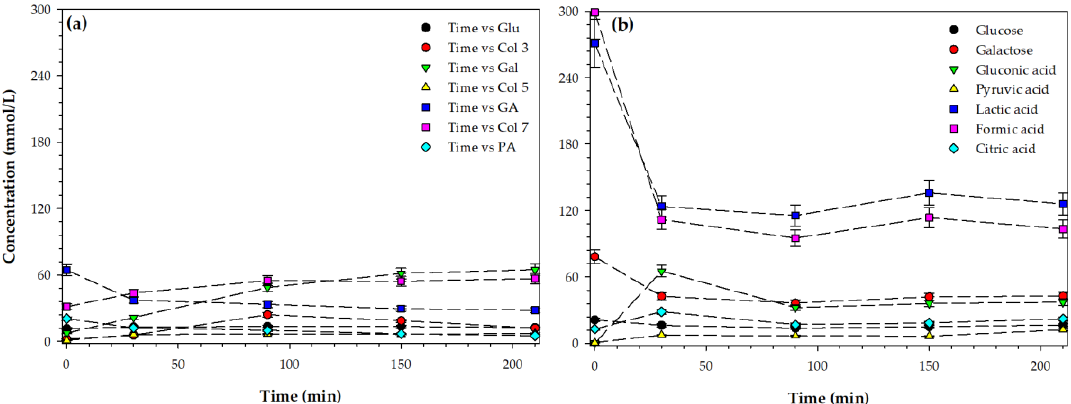
Figure 6. Formation of organic acids over time in: ( a ) sweet whey permeate (SWP), and ( b ) acid whey permeate (AWP). Temperature = 60 ◦ C and pressure = 60 bar, and stirring rate 600 rpm.